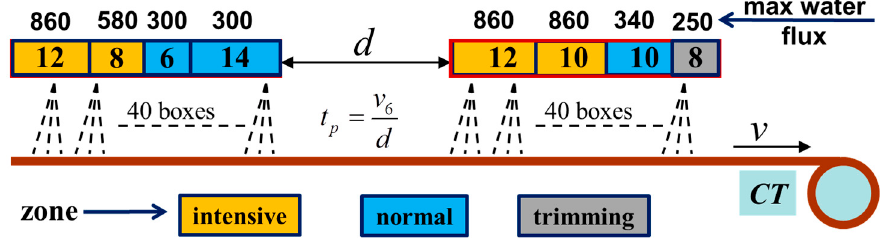
Figure 14. Schematic illustration of the laminar cooling system for steel strips. Number of boxes in each zone as well as the maximum water flux in various zones are given in the figure.